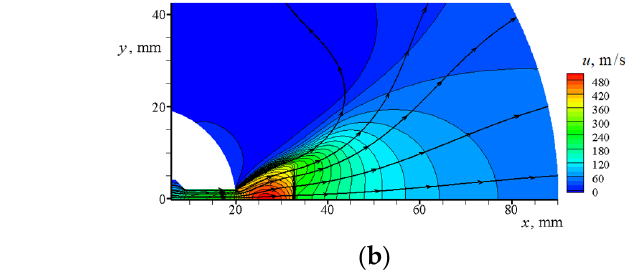
Figure 14. Calculated data for a gas jet without particles exhausting from a channel into a slot space with h = 0.2 mm: ( a )—Mach-number isolines M ( x , y ) and gas-flow streamlines; ( b )—longitudinal gas velocity u ( x , y ) and gas-flow streamlines.